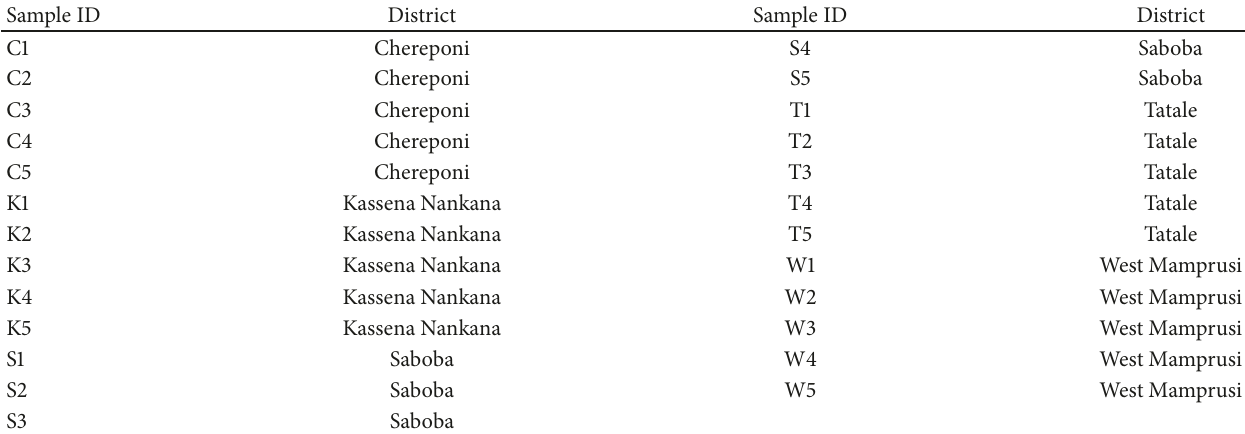
Table 1: Details of sesame accessions used for the